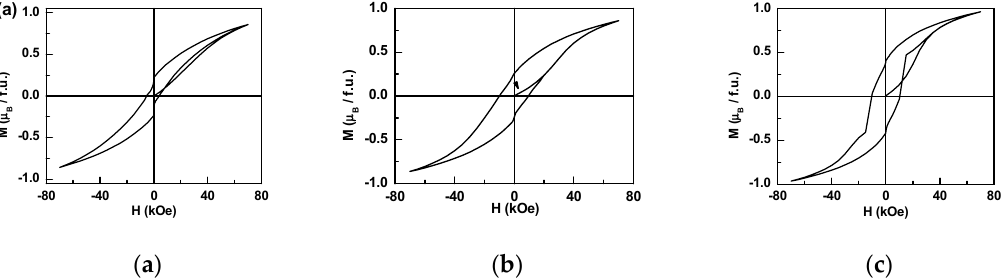
Figure 3. The hysteresis loop of the magnetization of Ir 0.9 Mn 1.05 Sn 1.05 , ( a ), Ir 0.9 Mn 0.95 Sn 1.15 ( b ), and Ir 0.9 Mn 0.9 Sn 1.2 ( c ).